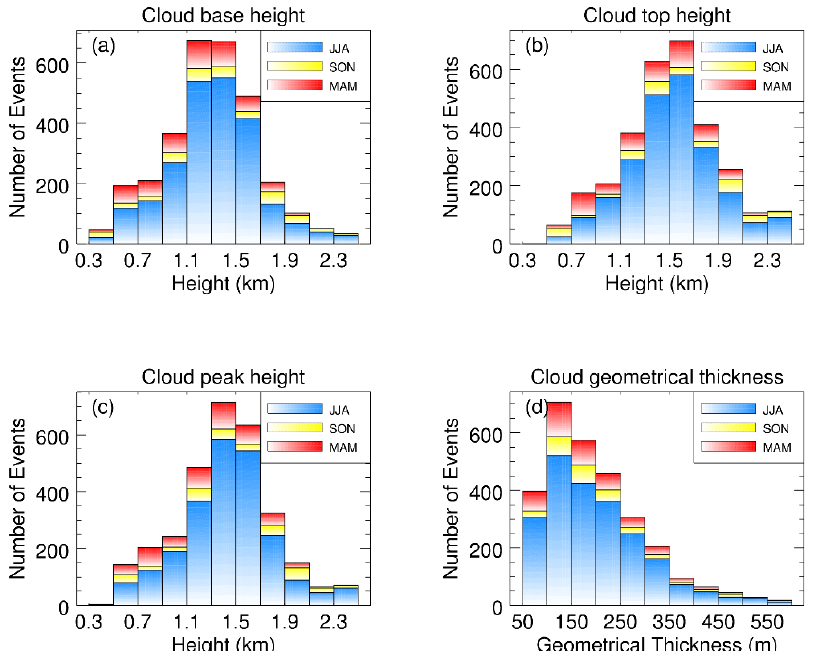
Figure 8. Distributions of ( a ) cloud base, ( b ) cloud top, ( c ) cloud peak heights, and ( d ) cloud geometrical thickness for the total of 3047 shallow cumulus cloud events observed from 2011 to 2019 at Wuhan, China. The blue bar, yellow bar, and red bar represent the number of events in summer (June, July, and August), in autumn (September, October, and November), and in Spring (March, April, and May), respectively.